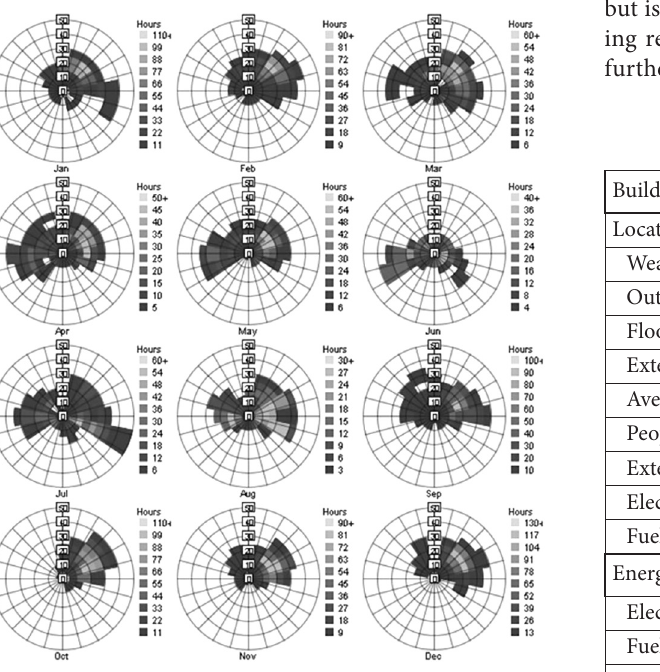
Figure 12. Wind rose